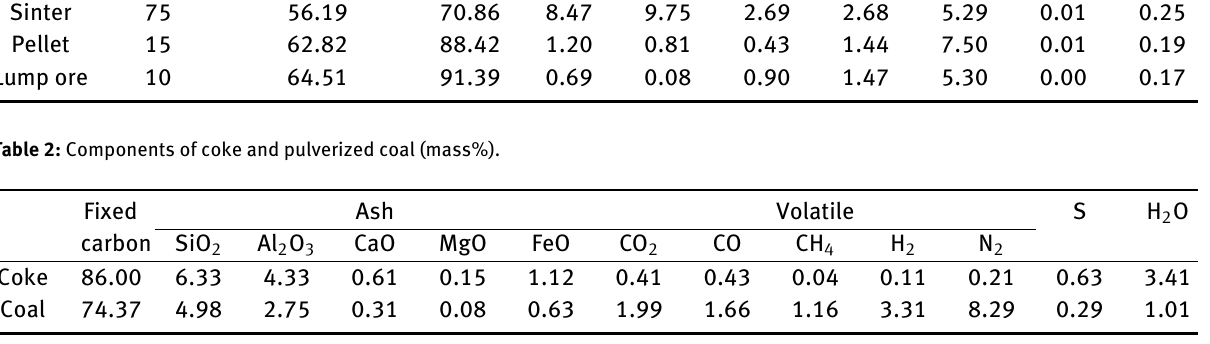
Table 1: Burden system and chemical compositions of iron-bearing feed (mass%). Burden TFe (total Fe) Fe 2 O 3 FeO CaO MgO Al 2 O 3 SiO 2 S/2 others system Sinter 75